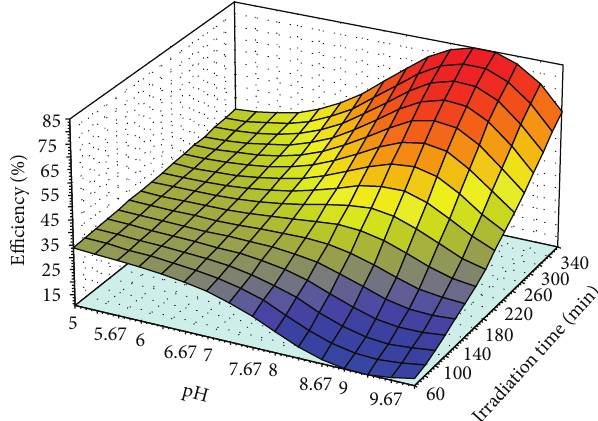
Figure 8: The variation of the efficiency in different concentration of m -cresol from 25 to 80 mg/L with irradiation time (60 − 360min); the pH was 7.5 and amount of the photocatalyst was 2